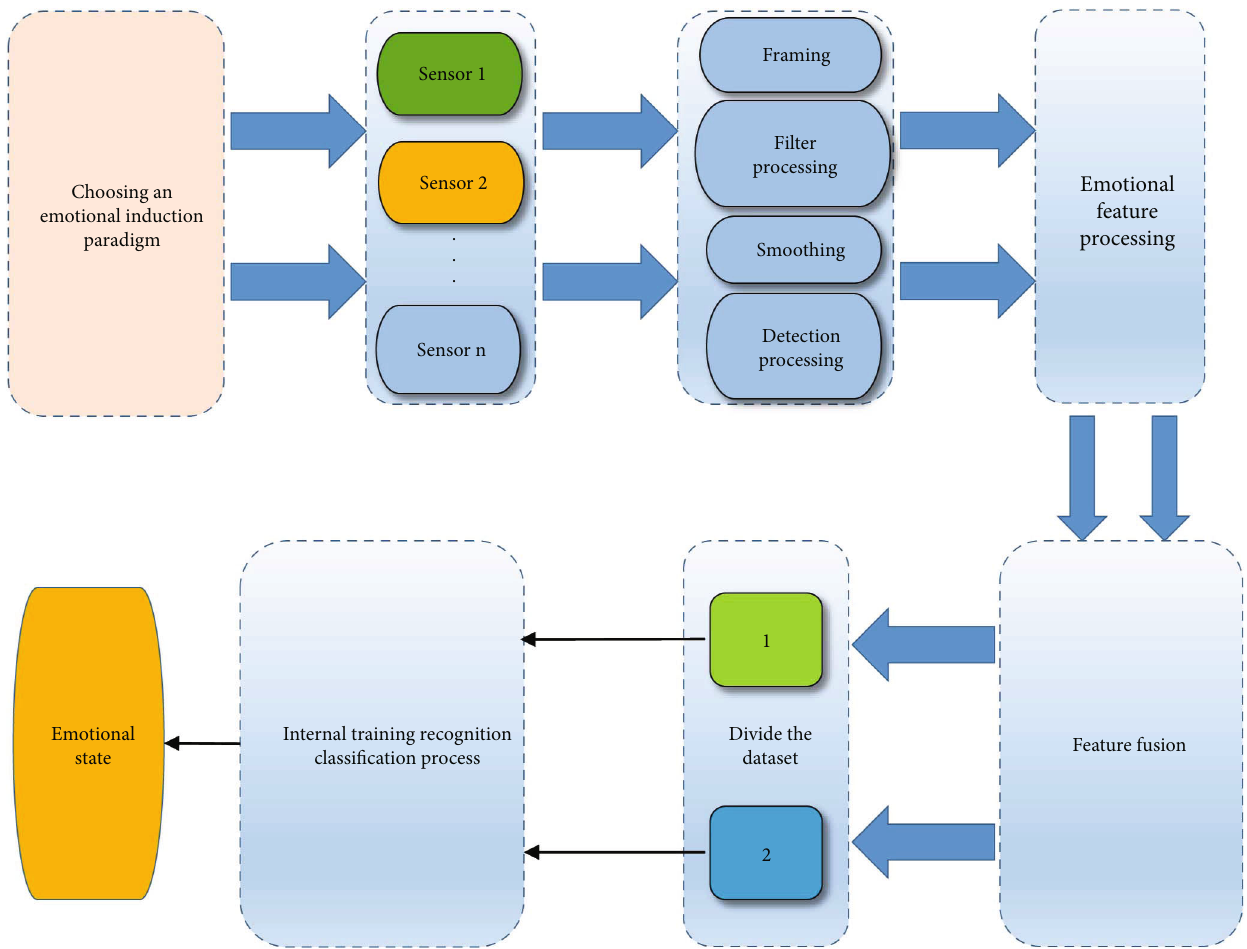
Figure 1: Step diagram of emotional and psychological